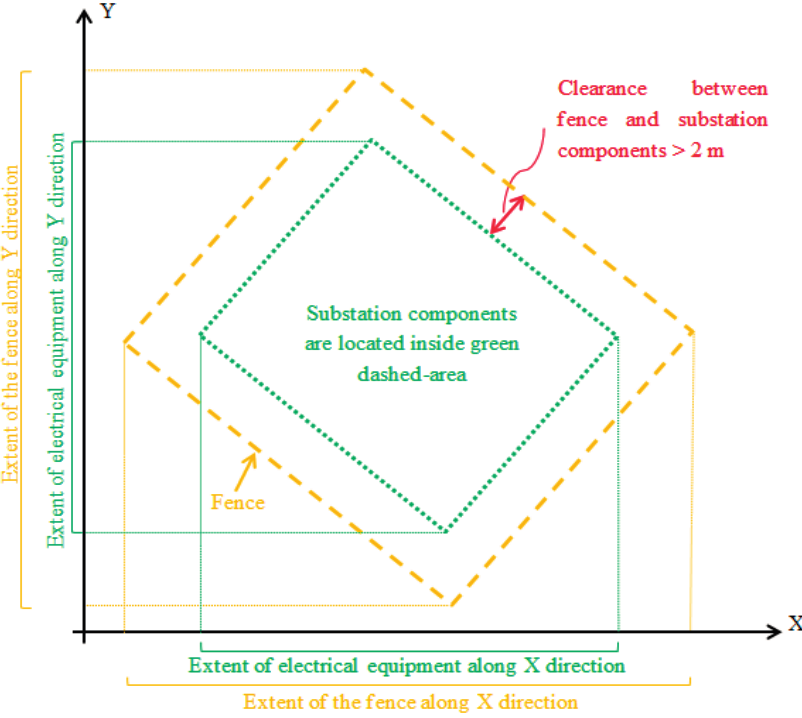
Figure 6. The clearance between the fence and other components in a substation site (plan